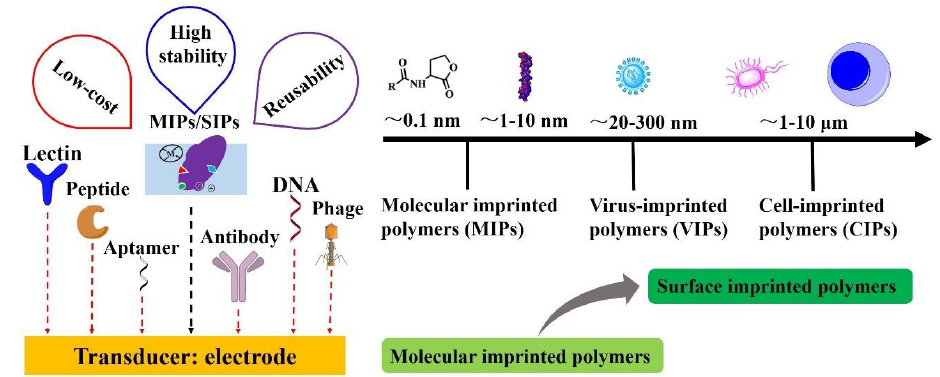
Figure 1. Various receptors for electrochemical biosensors applied in infectious diseases biomarker detection and size distribution covering all the analytes in this review, including small molecular, toxin protein, virus, bacteria, and fungal cells as plotted on a nanometer scale